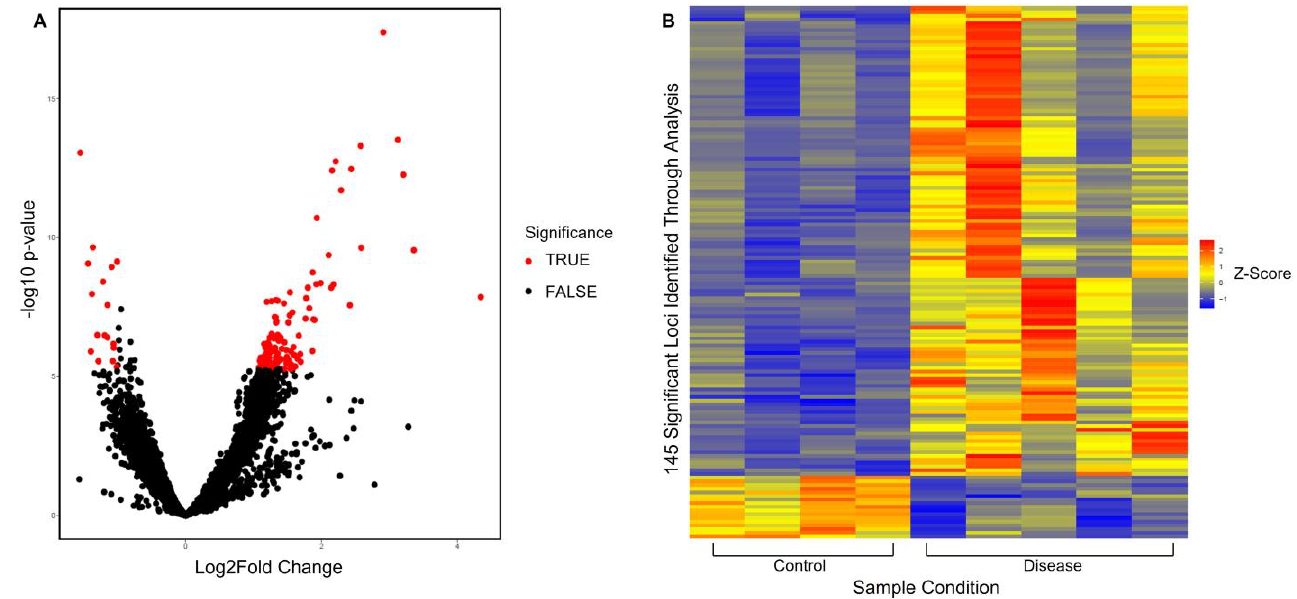
Figure 2. Analysis of significant peaks identified from H3K27me3 sequencing data. ( A ) A volcano plot showing significance of peaks identified for H3K27me3, where the x -axis is log2fold change and the y -axis is unadjusted p -value. The red dots (TRUE) indicate significant peaks (absolute log2fold > 1 and adjusted p < 0.05), and black dots (FALSE) indicate peaks with no significance. ( B ) Heatmap looking at the size of significant peaks identified from H3K27me3 sequencing data across sample conditions, control (hamstring), and disease (late-stage RC supraspinatus tendon). Table 1. DAVID functional annotation chart based on H3K27me3 gene list from peak annotation.